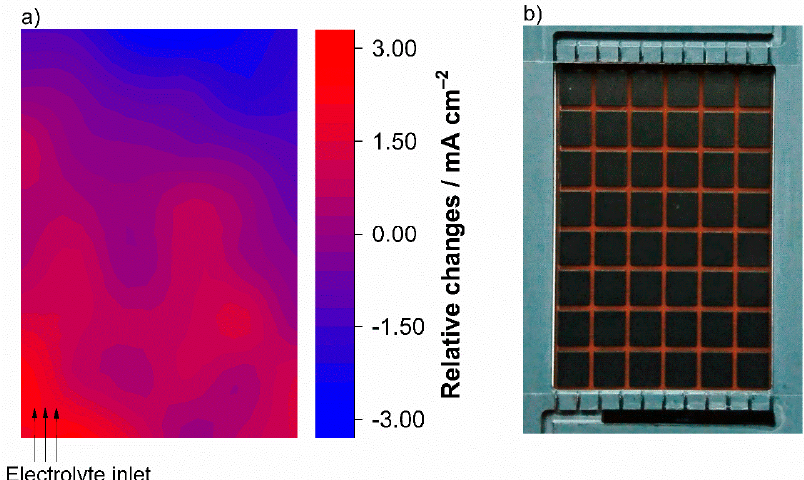
Figure 6. Current density distribution as a result of electrolyte inlet modification ( a ). Test conditions were charging with 25 mA cm − 2 and an electrolyte flow rate of 2.5 mL min − 1 cm − 2 ( λ > 100), and the